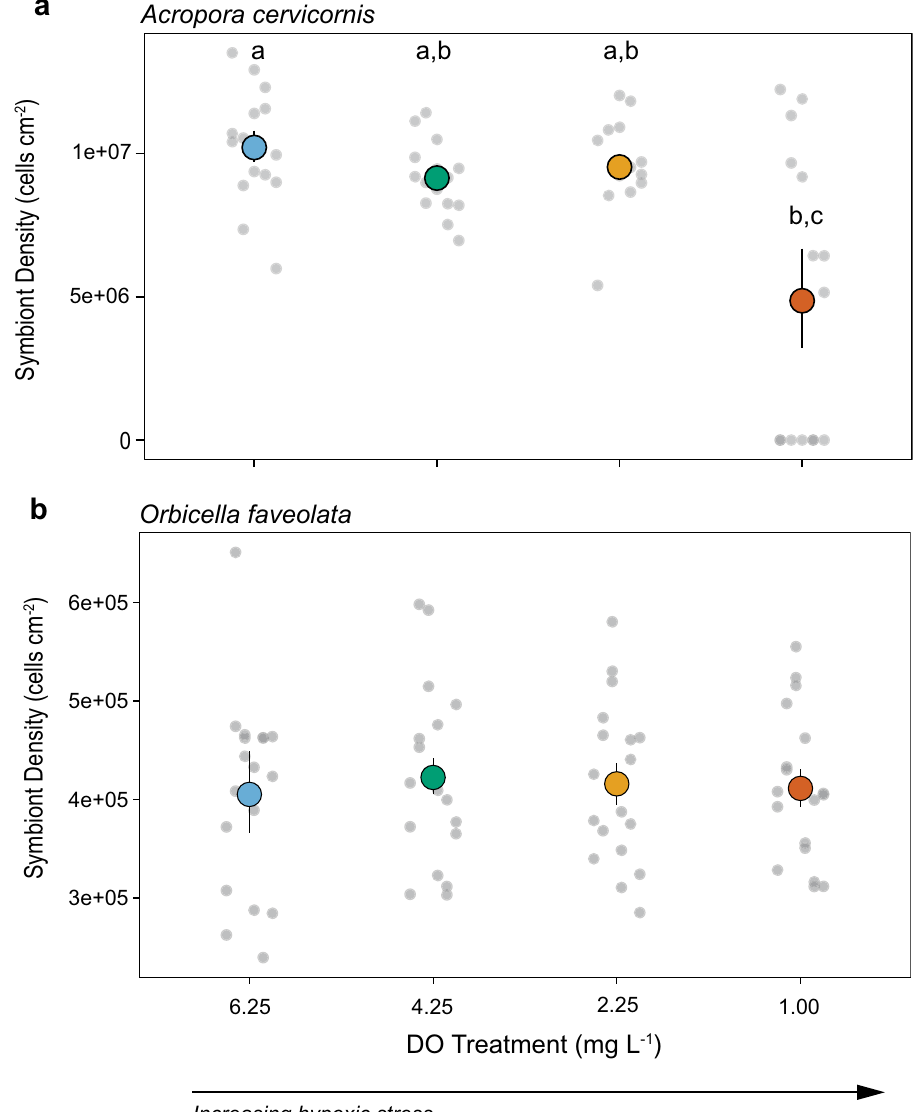
Figure 4. Coral symbiont densities under deoxygenation. ( a ) Mean ± SE symbiont densities at the end of the 5-day experiment for Acropora cervicornis and ( b ) the 11-day experiment for Orbicella faveolata (n = 3). The grey circles show individual data points and colored circles represent means across all genotypes within a treatment. Treatments with different lower-case letters are statistically different at P < 0.05.